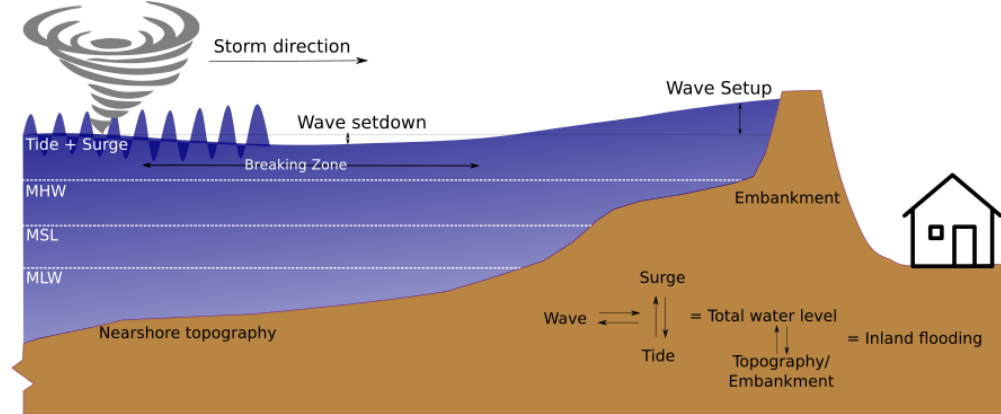
Figure 2. Conceptual diagram of the involved processes that determine the water level evolution and its interaction with the controls deter- mining the inland flooding.